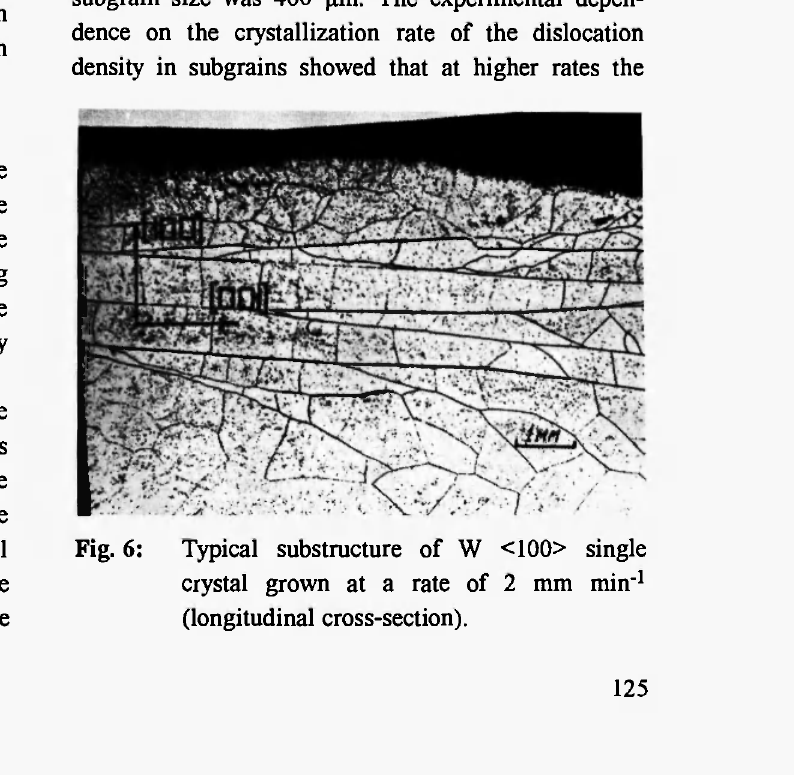
Fig. 5: Oxygen content in the Nb single crystals vs. numbers of liquid zone passes in vacuum